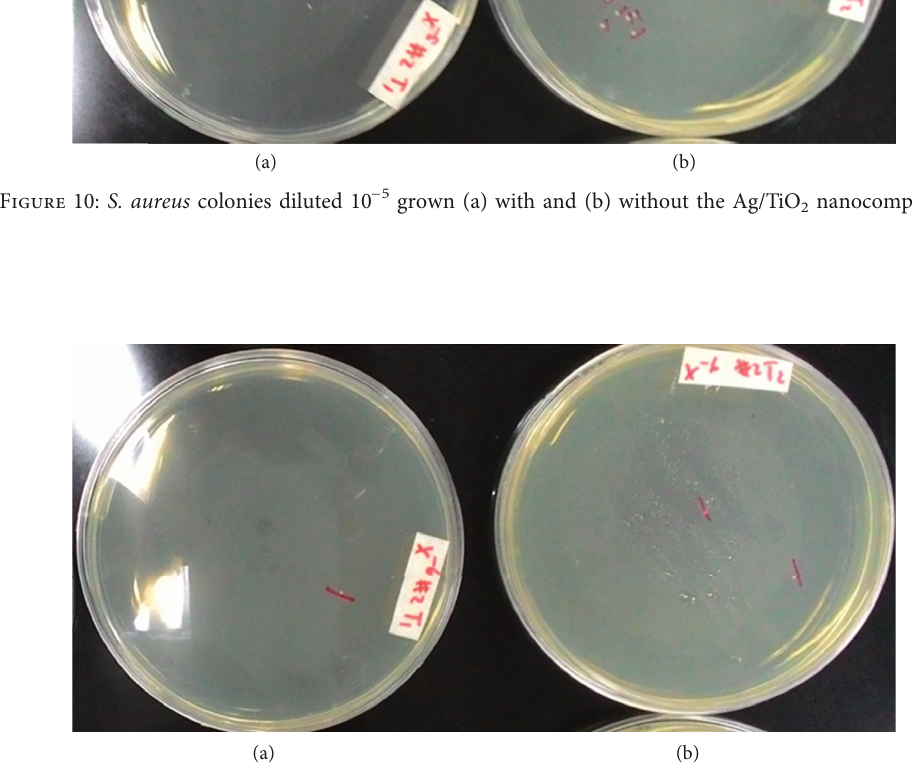
Figure 11: S. aureus colonies diluted 10